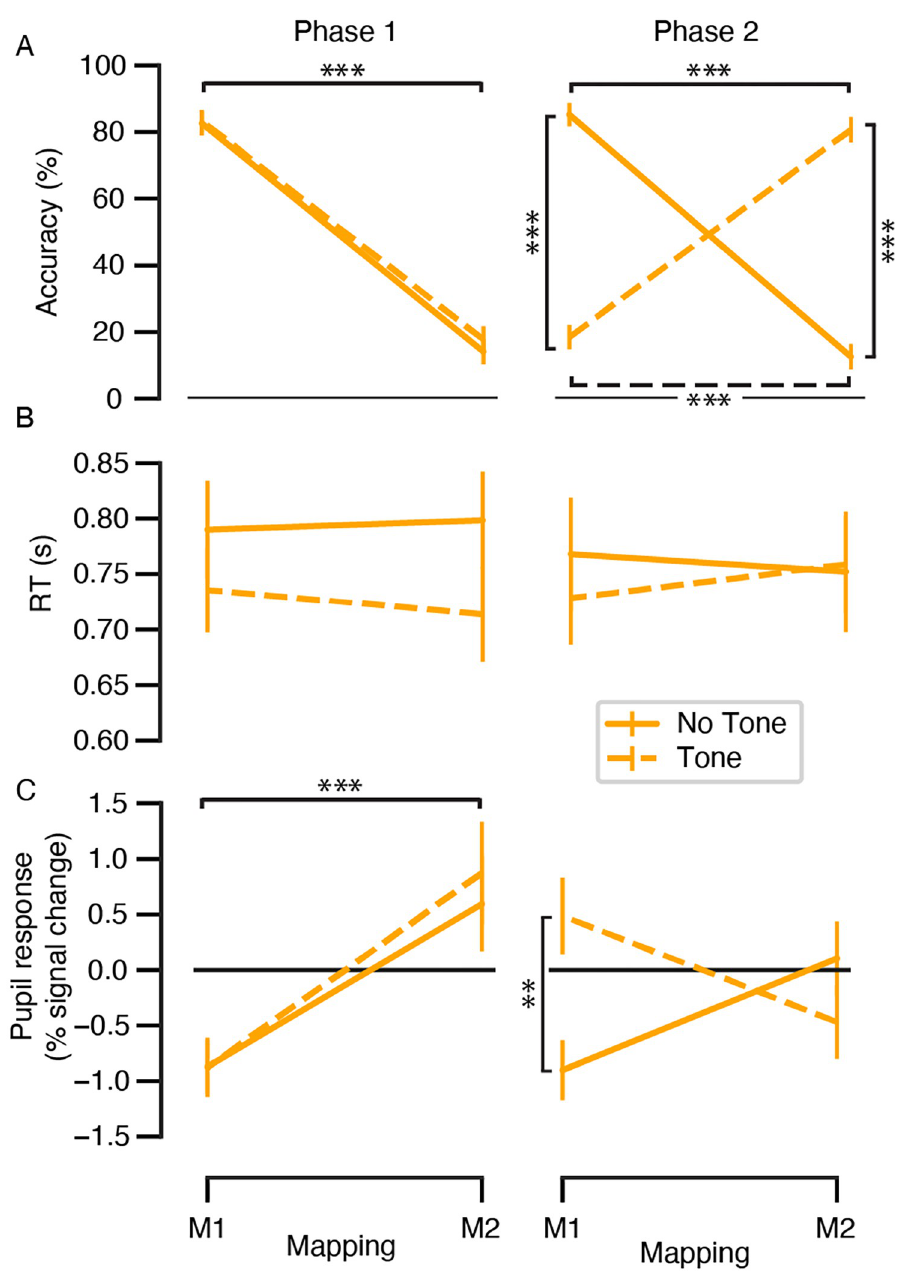
Fig 2. Cue-target prediction task results. ( A ) Prediction accuracy, ( B ) mean RT, and ( C ) target-locked pupil dilation as a function of visual cue-target mapping condition (M1 vs. M2), the presence of the auditory cue (tone vs. no tone), and task phase (first vs. second). Results of the 3-way repeated measures ANOVAs are given in Table 1. Significance refers to post hoc t-tests: �� p < .01, ��� p < .001. Error bars, s.e.m. ( N = 30). Note that the frequencies of the visual cue- target mappings change in the second phase for the tone